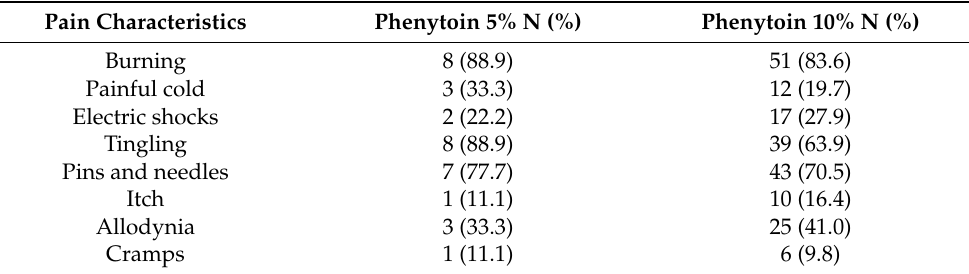
Table 2. Pain characteristics of neuropathic